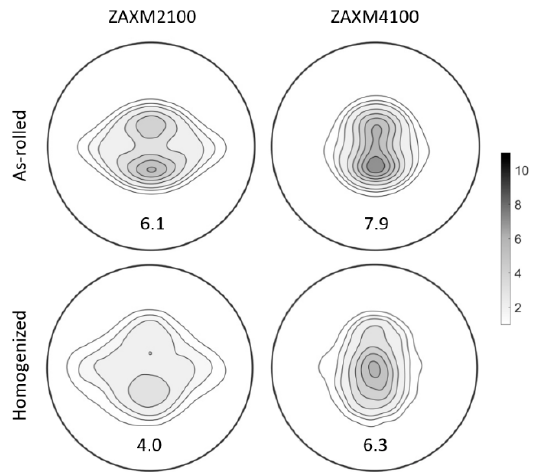
Figure 10. Calculated pole figures of as-rolled and homogenized ZAXM2100 and ZAXM4100 alloy sheets.